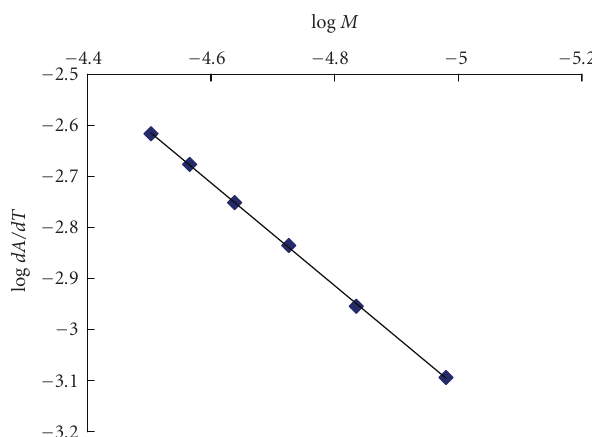
Figure 7: Calibration Plot of logarithm rate of the reaction against logarithm molar concentration of cefotaxime for initial rate method.